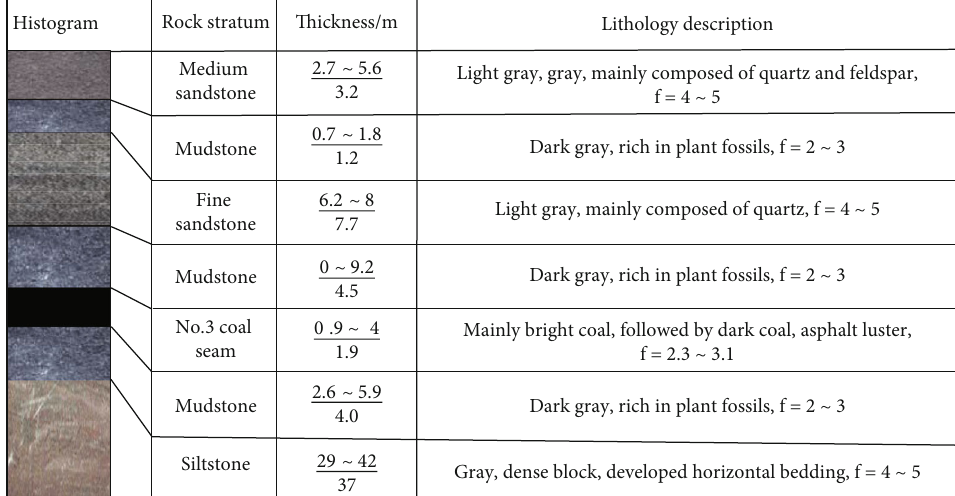
Figure 3: Coal and rock strata